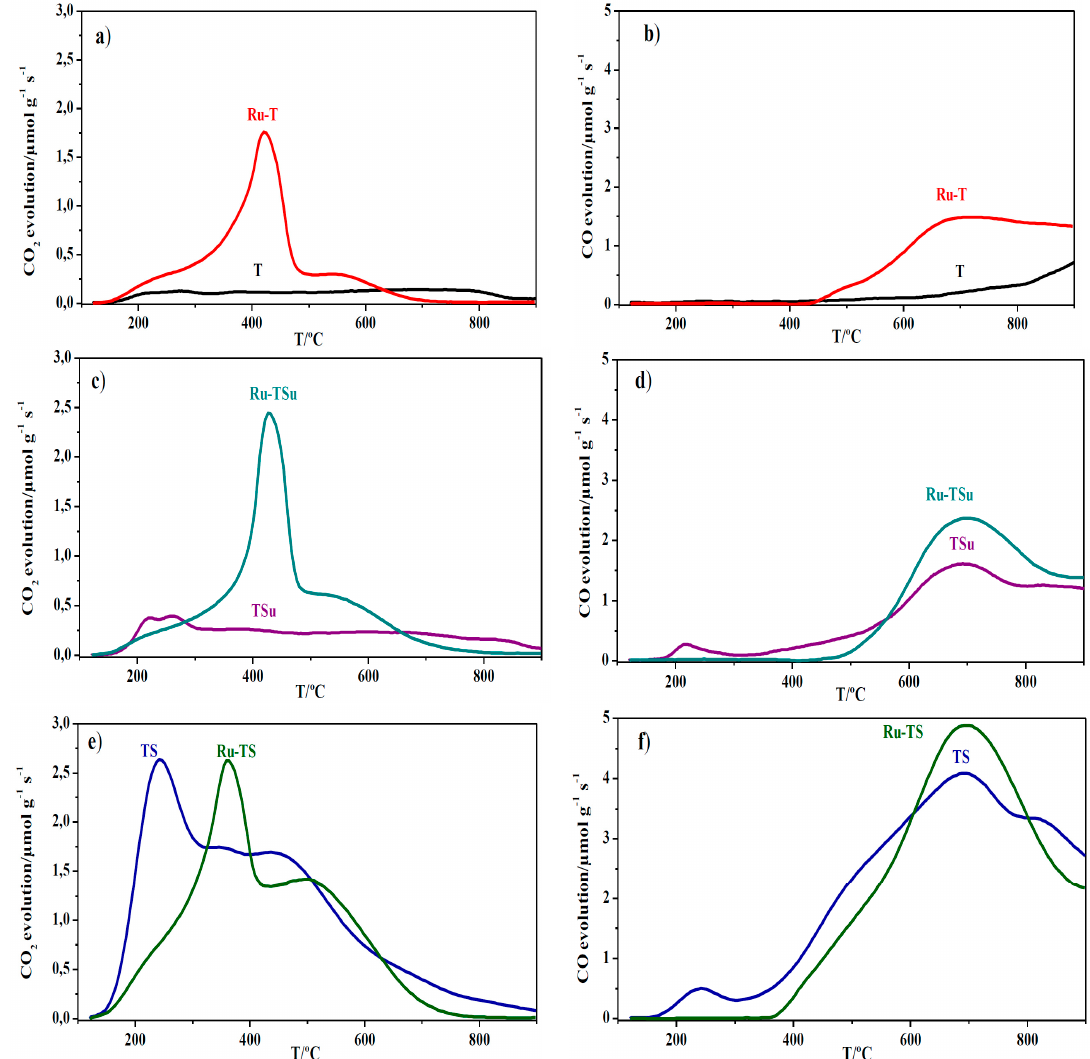
Figure 1. TPD profiles of ( a , b ) samples T and Ru-T, ( c , d ) samples TSu and Ru-TSu, and ( e , f ) samples TS and Ru-TS. Left—CO 2 evolution; right—CO evolution.